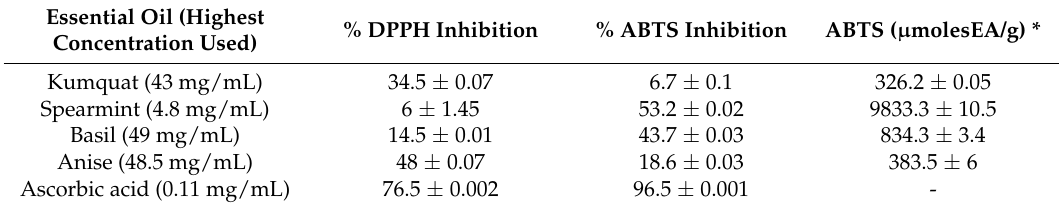
Table 6. Antioxidant activity of the essential oils in the maximum concentration tested using the DPPH and ABTS